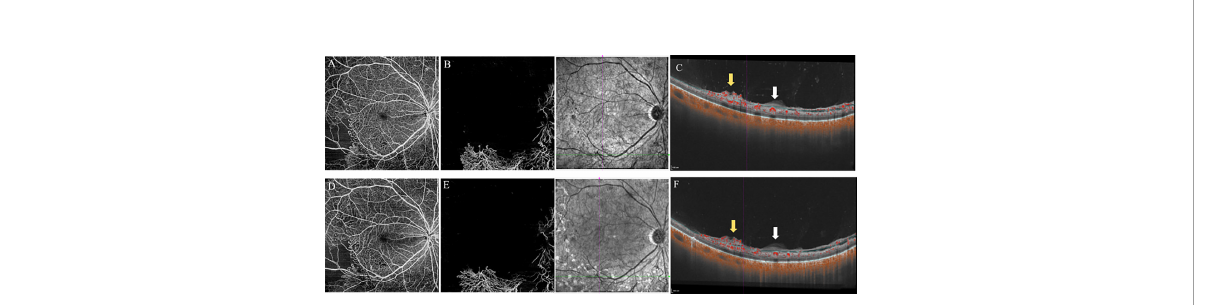
within the 95% level of agreement (LoA, 0.84 – 1.20). The